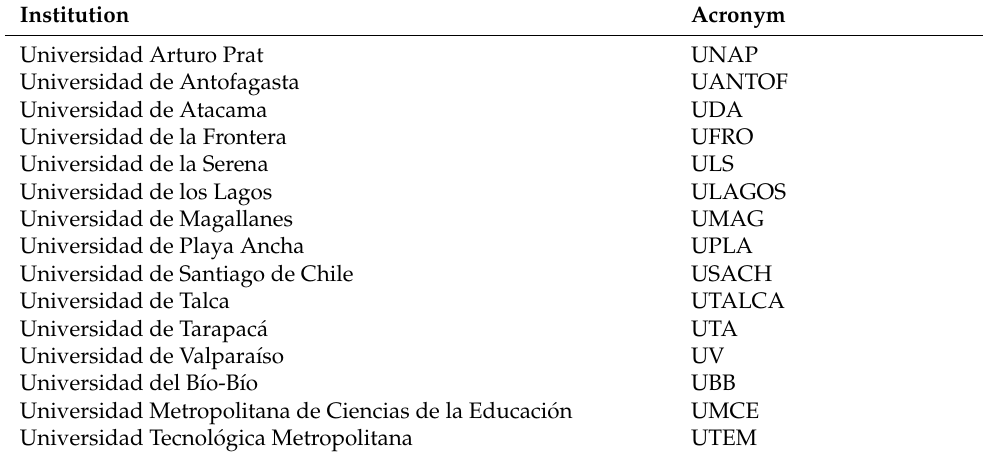
Table 1. Chilean state universities 1 with institutional policy of incentives for scientific